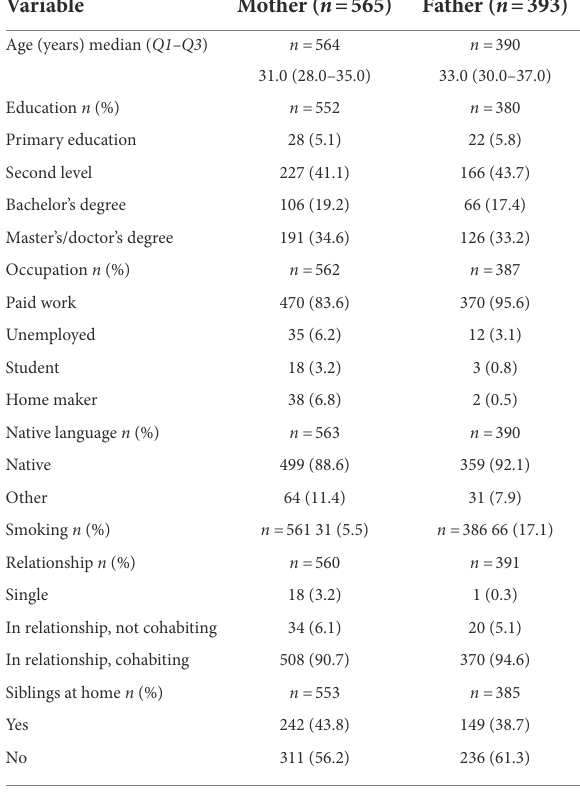
TABLE 3 The duration of parent-infant closeness (minutes per 24 h) during the diary days in the 23